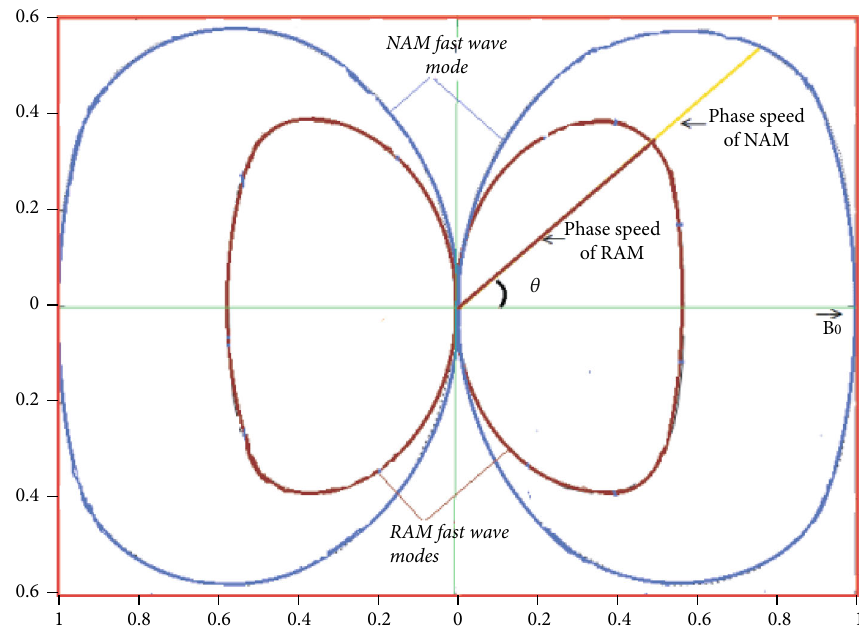
Figure 3: Polar plots of the phase speeds of fast mode for RAM and NAM two-component plasma.